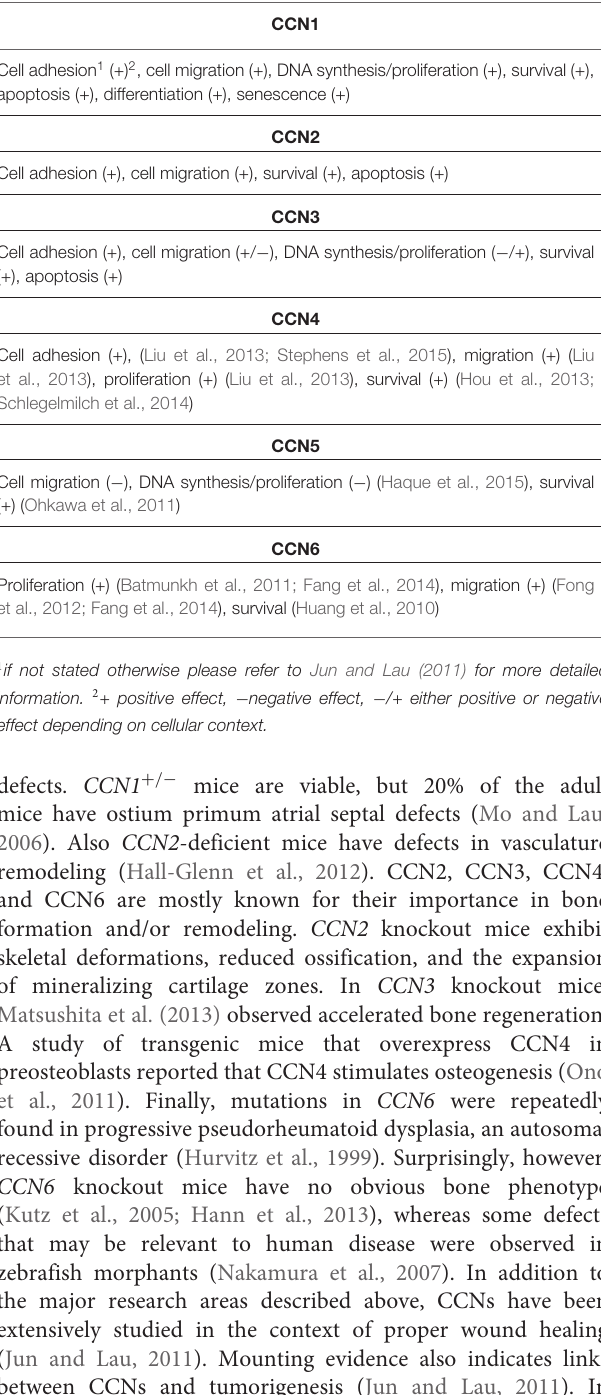
TABLE 2 | Cellular functions of CCN proteins